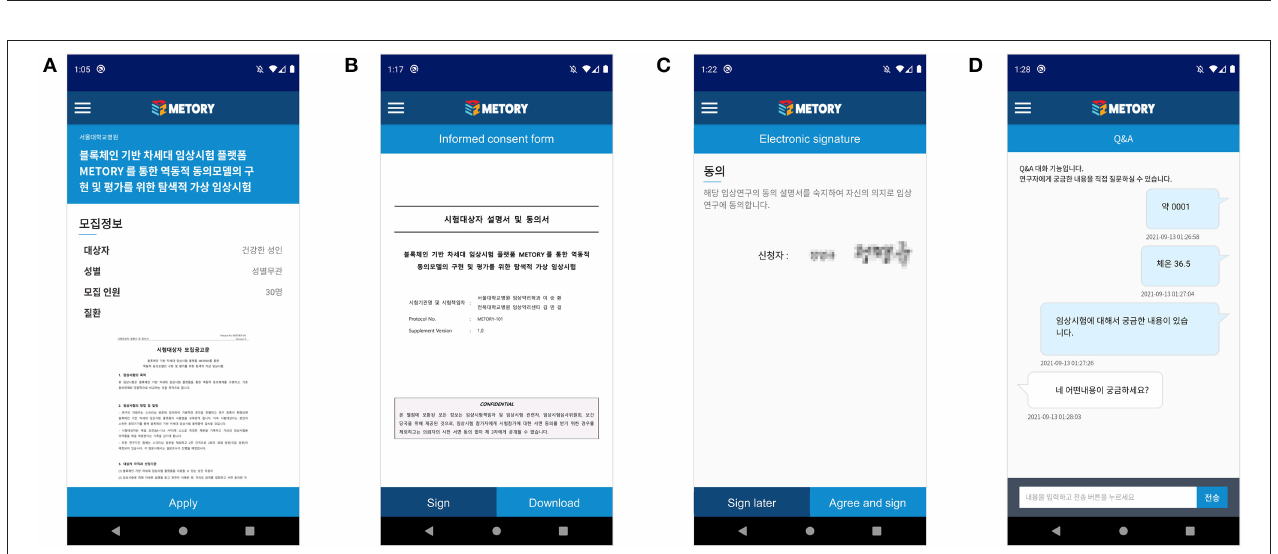
FIGURE 4 | Web interface of the study and consent management: a dashboard for the study management (A) , and the signed consent form where hash values were attached (B) .